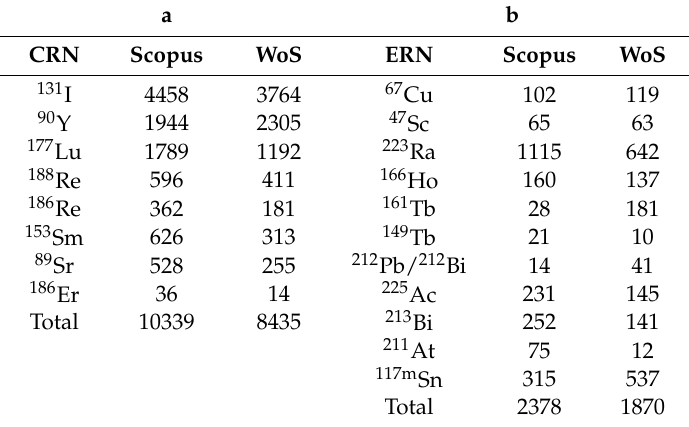
Table 5. Radionuclide data representing the number of papers extrapolated from the Scopus and Web of Science (WoS) databases published for each radionuclide over the last 10 years